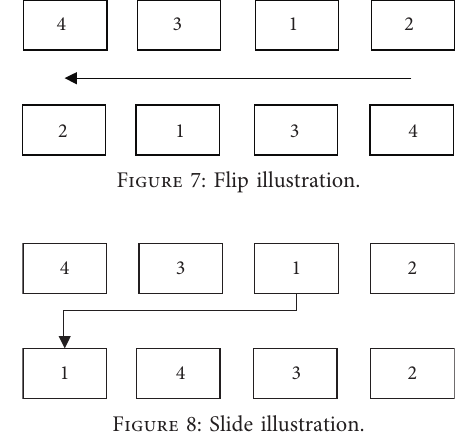
Figure 7: Flip illustration.